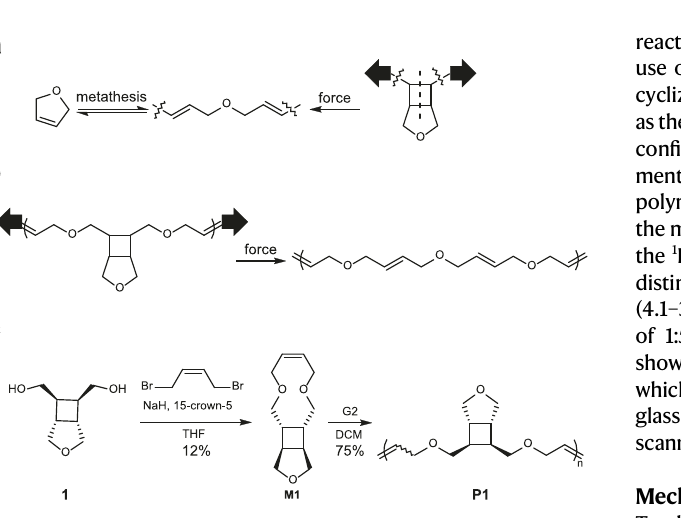
Fig. 3 | Design and synthesis of the polymer that can mechanochemically generate PDHF. a Reversible transformation between DHF and PDHF, and a mechanochemical pathway for a PDHF unit. b Structure of polymer that can mechanochemically generate PDHF. c Synthetic scheme of M1 and P1